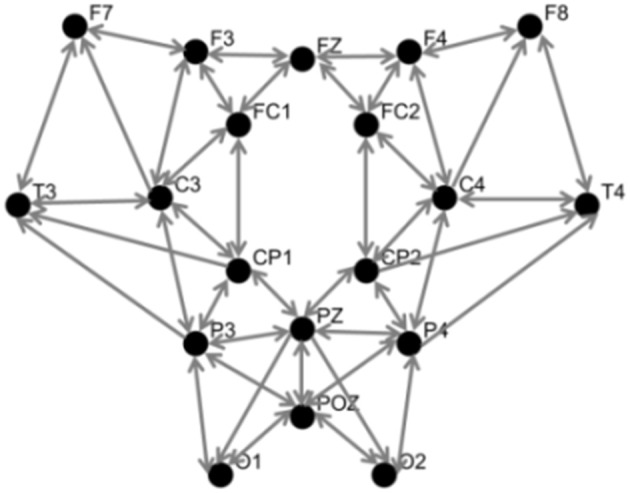
Topographic view of EEG electrodes showing neighborhood pattern for Laplacian spatial filtering. Inward arrows to each node indicate the corresponding neighbors used for spatial filtering.